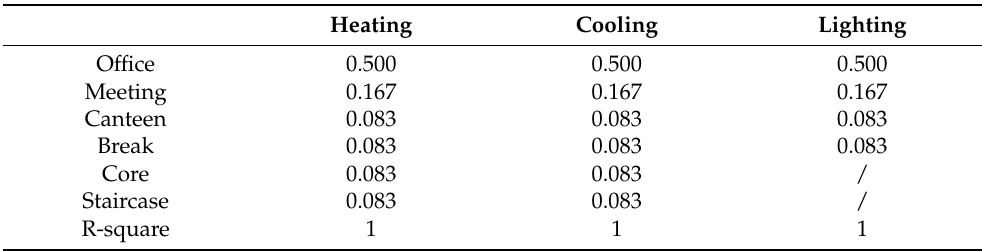
Table 6. The regression coefficients resulting from three rounds of regression analysis for heating, cooling and lighting demand, respectively, between energy demand of the layout and energy demands of different functions. Heating Cooling Lighting Office 0.500 0.500 0.500 Meeting 0.167 0.167 0.167 Canteen 0.083 0.083 0.083 Break 0.083 0.083 0.083 Core 0.083 0.083 /